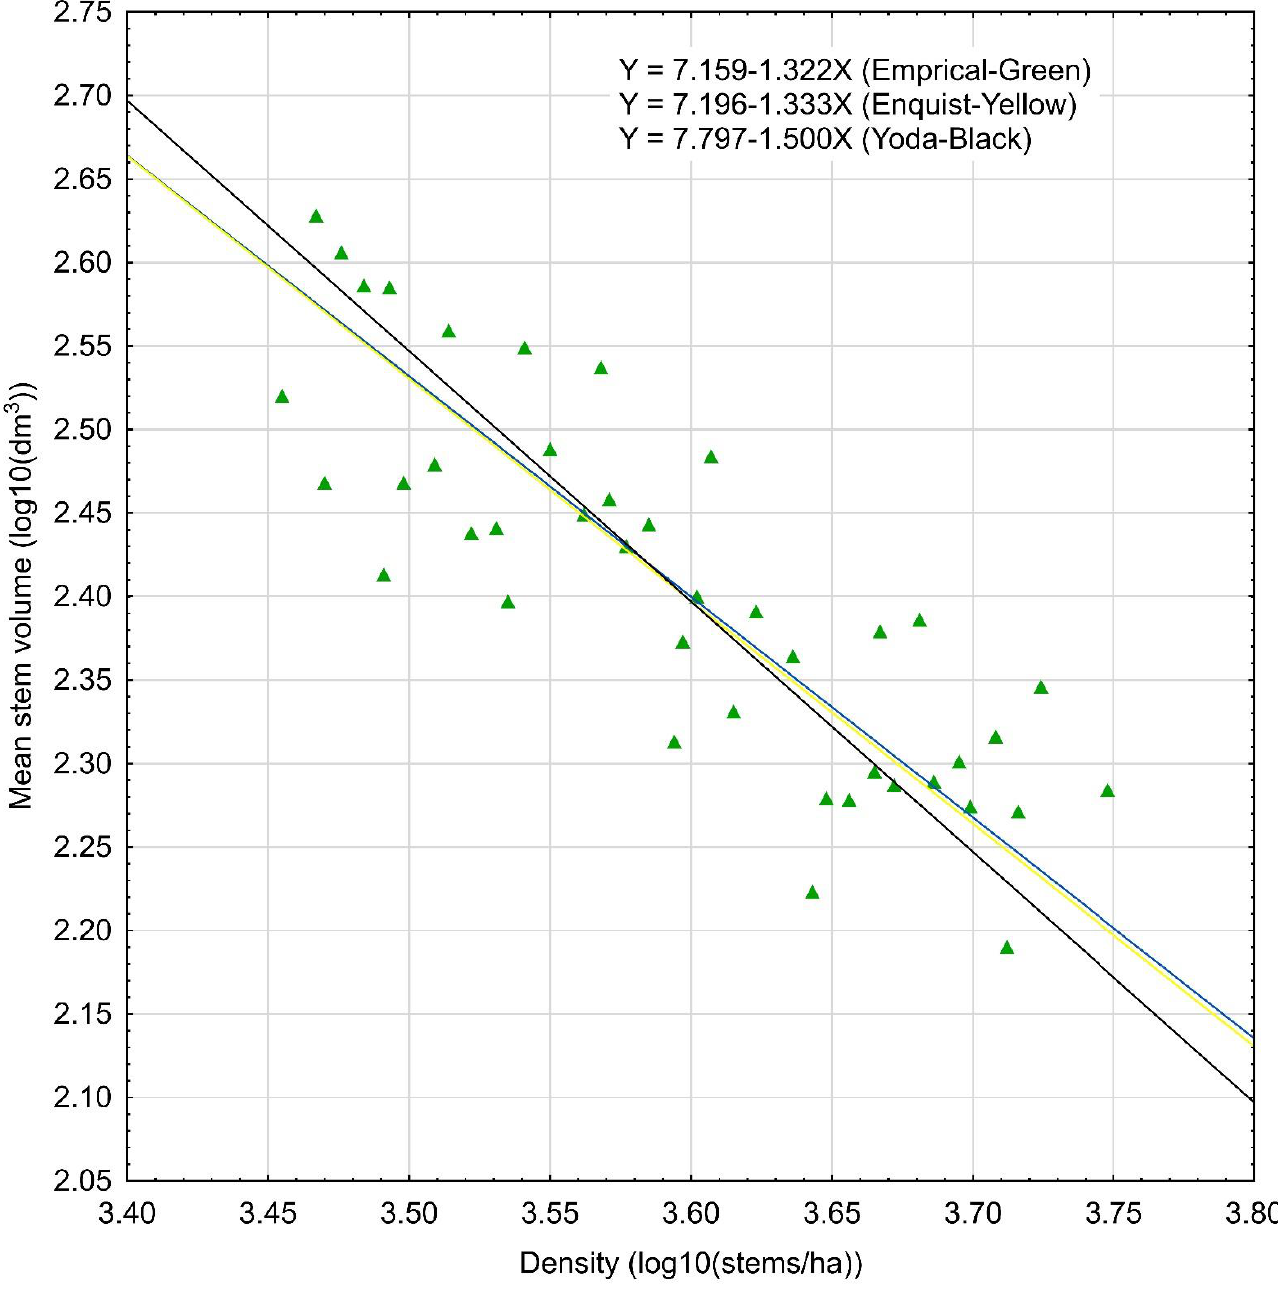
Figure 1. Graphical illustration of the logarithmic asymptotic mean stem volume (log 10 (dm 3 )) – density (log 10 (stems/ha)) conceptual-based self-thinning relationships for red pine with the empirical relationship and parameterization data superimposed: (1) Yoda’s [20] theoretical-based model (solid black line); (2) Enquist’s [44] theoretical-based slope (solid yellow line); and (3) empirical-based parameterized relationship (solid green line).